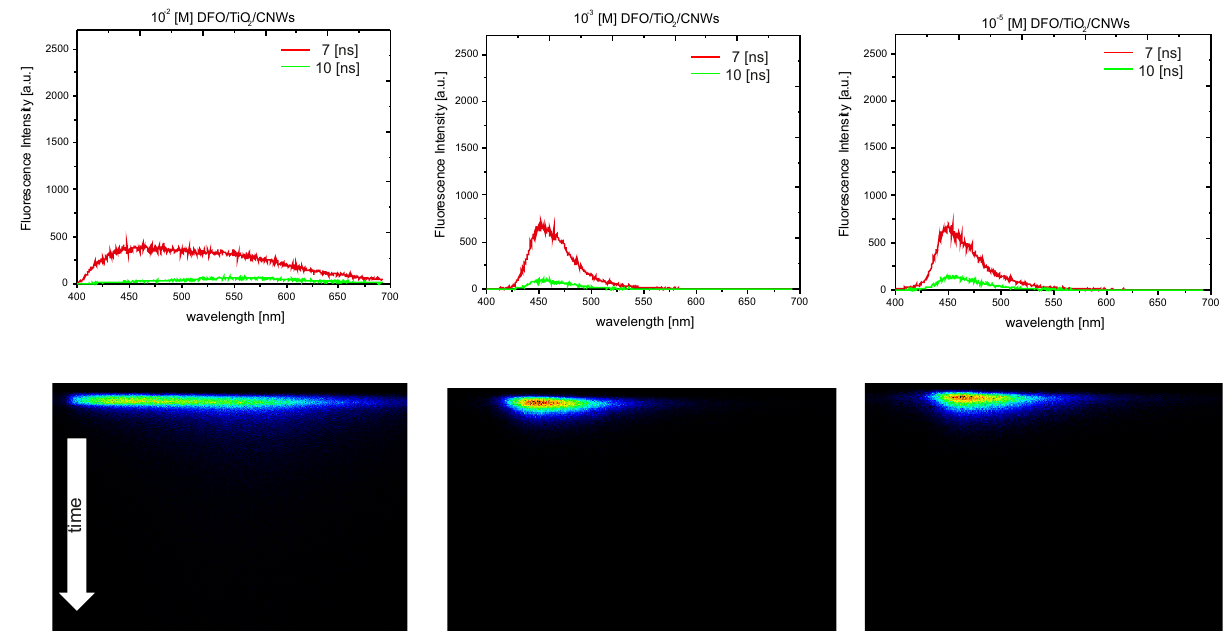
Figure 4. Time-resolved emission spectra of DFO/TiO 2 /CNW thin films for different DFO concentra- tions: 10 − 2 [M] DFO/TiO 2 ; 10 − 3 [M] DFO/TiO 2 ; 10 − 5 [M] DFO/TiO 2 . The excitation wavelength was 380